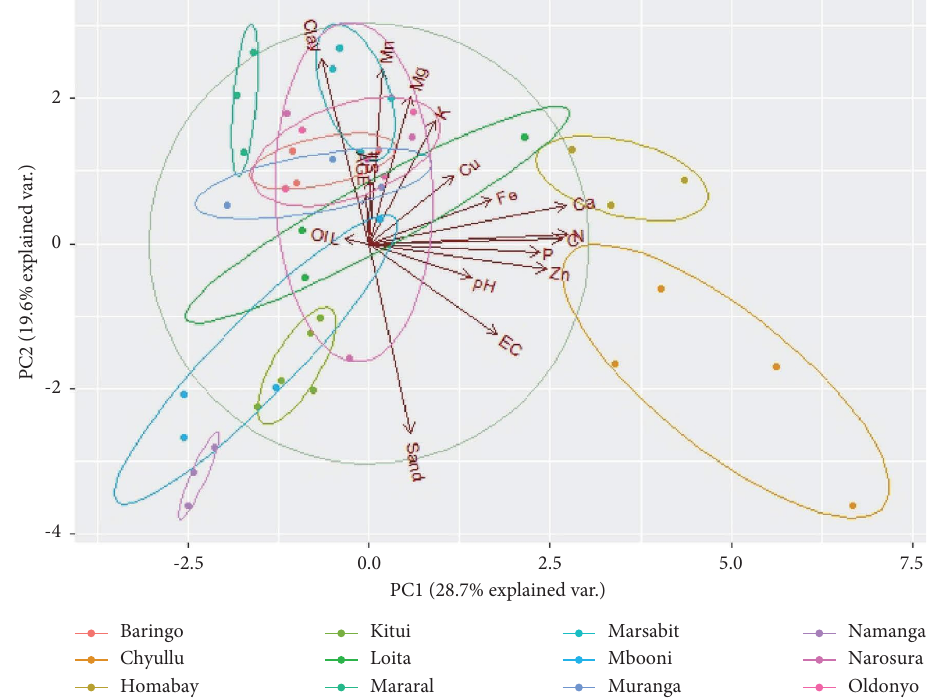
Figure 3: Principal component analysis of soil nutrients, texture, oil yield, and tree age at diferent Sandalwood study sites. NB: Te circled clusters in the biplot represent the